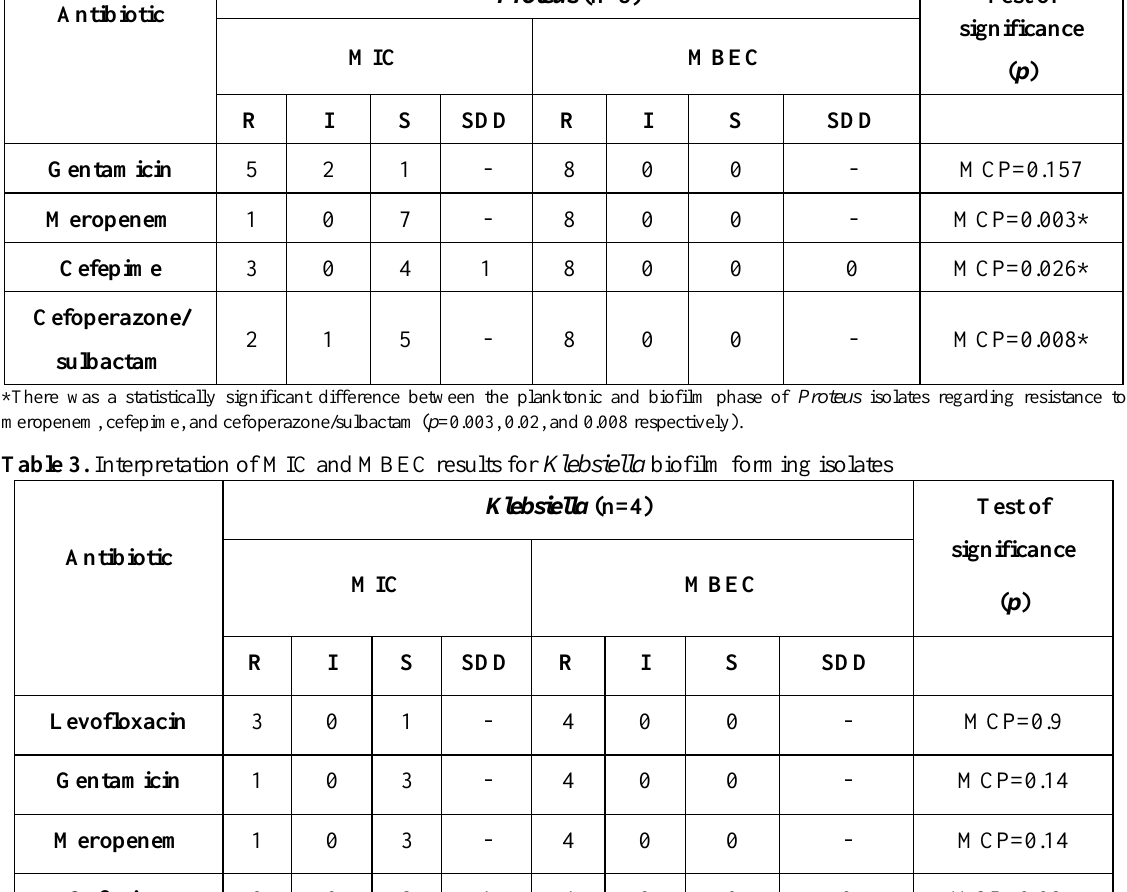
Table 2. Interpretation of MIC and MBEC results for Proteus biofilm forming isolates Antibiotic